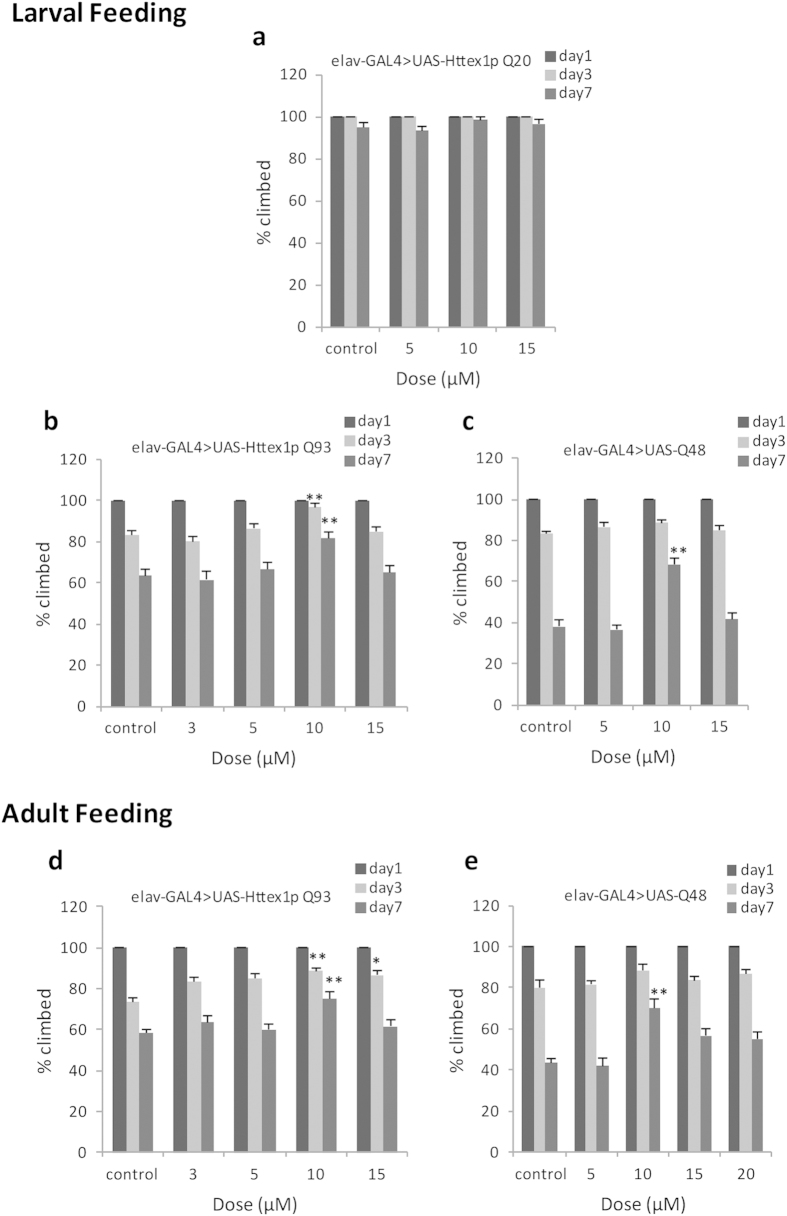
Curcumin improves locomotor dysfunction of polyQ flies.Climbing ability of adults aged day 1, 3 and 7 post eclosion, fed normal or curcumin-containing food was evaluated. (a) All doses of curcumin fed since larval stage had no detectable effect on locomotor activity of non pathogenic Httex1p Q20 flies. Administration of 10 μM curcumin since larval stage (b,c) or only during adult period (d,e) suppressed motor dysfunction in flies expressing Httex1p Q93 and Q48. Comparison was made between control and drug treated flies of same age. For each condition, the climbing ability of two groups of 10 flies were monitored (n = 20) for a total of 6 trials. Analysis of data was done using the Kruskal-Wallis test followed by Mann-Whitney test with Bonferroni correction to adjust p-values; data represents mean ± SEM (**p < 0.01; *p < 0.05, compared with control).